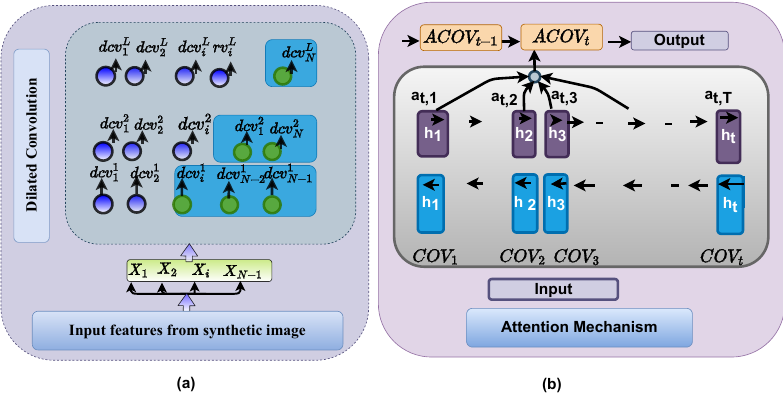
Figure 6. ( a ) Dilated CNN and ( b ) Attention